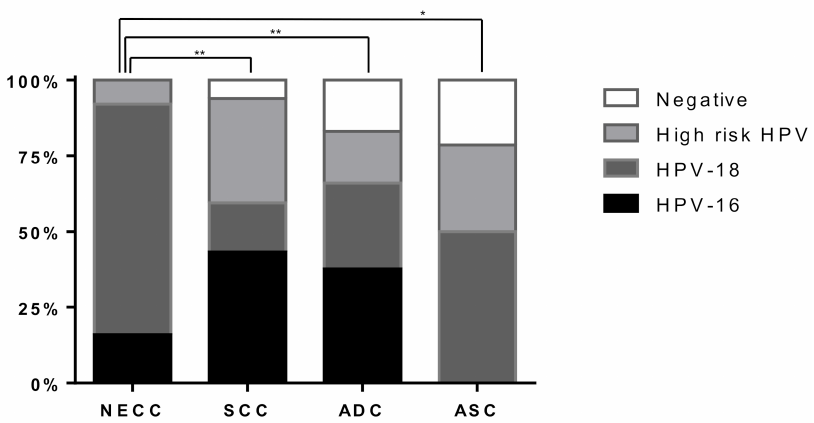
Figure 4. Correlation between histological types and human papillomavirus (HPV) genotypes in 272 cervical cancer specimens. HPV genotypes were compared with neuroendocrine carcinoma (NEC) and other histological types of cervical cancer, including squamous cell carcinoma (SCC), adenocarcinoma (ADC), and adenosquamous carcinoma (ASC). The P-value was calculated using the Fisher’s exact test, * p < 0.05, ** p <